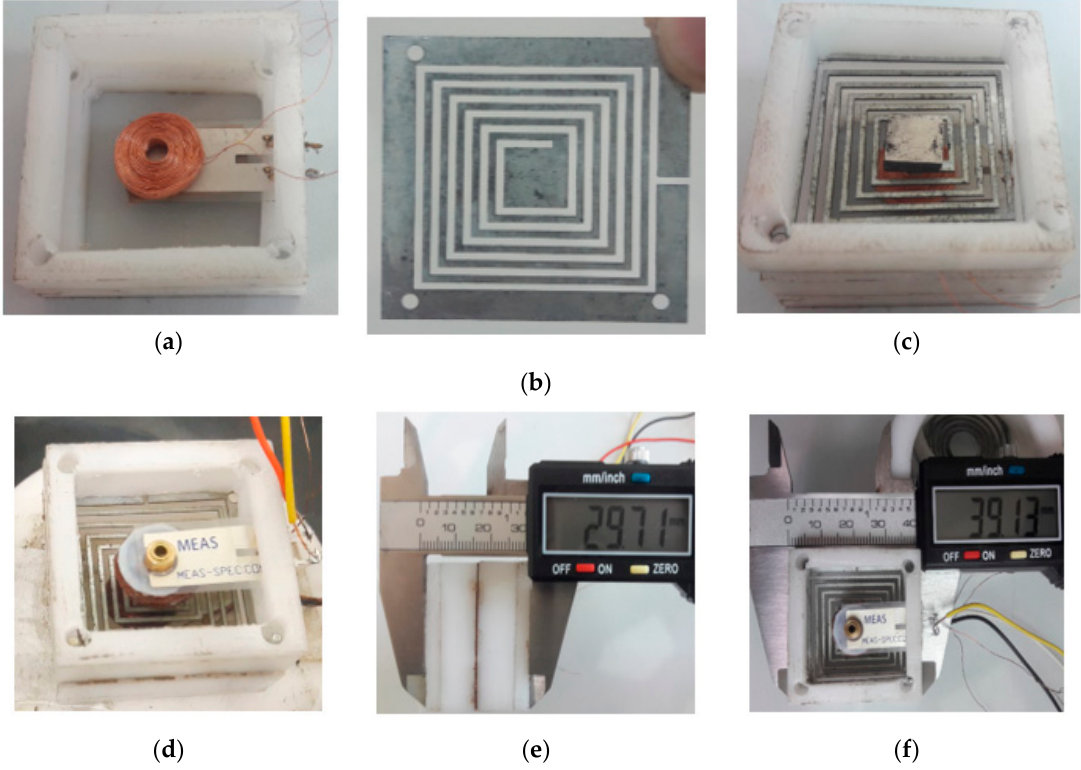
Figure 5. Photographs of the developed HIEH during assembly stages: ( a ) PVDF-I holding wound coil-I is clamped between Teflon spacers, ( b ) square spiral spring holding with a central platform for top and bottom magnets, ( c ) the spring holding top and bottom magnets is sandwiched between the spacers, ( d ) top view of the assembled HIEH, ( e ) height of the harvester, ( f ) side length of the HEH. Upper and lower PVDF (Meas-spec) polymers (25 mm × 13 mm) were used as cantilever beams. Two wounds of conducting coils ( Φ 12 mm × 4 mm): coil I and coil II, were produced from 80 µ m enameled copper wire, and fixed to the under-side (to face magnets), at the tip of cantilever beams, and just in-line and close to the respective (upper and lower) magnets, for maximum power generation. The PVDF-I and PVDF-II were securely clamped by the upper and lower Teflon spacers; with its terminals left outside to allow easy electrical connections and the measurement of output signals, Figure